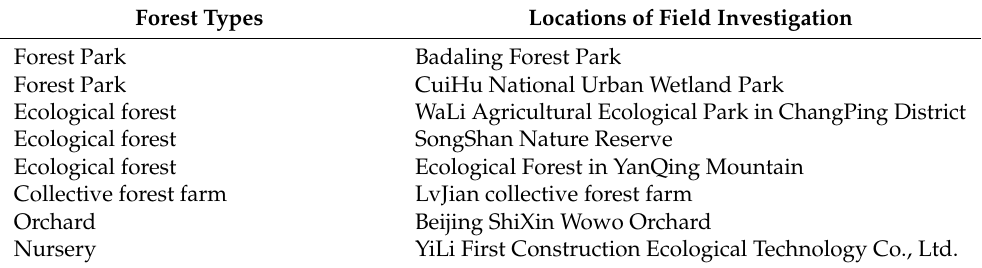
Table 3. Locations of field investigation.